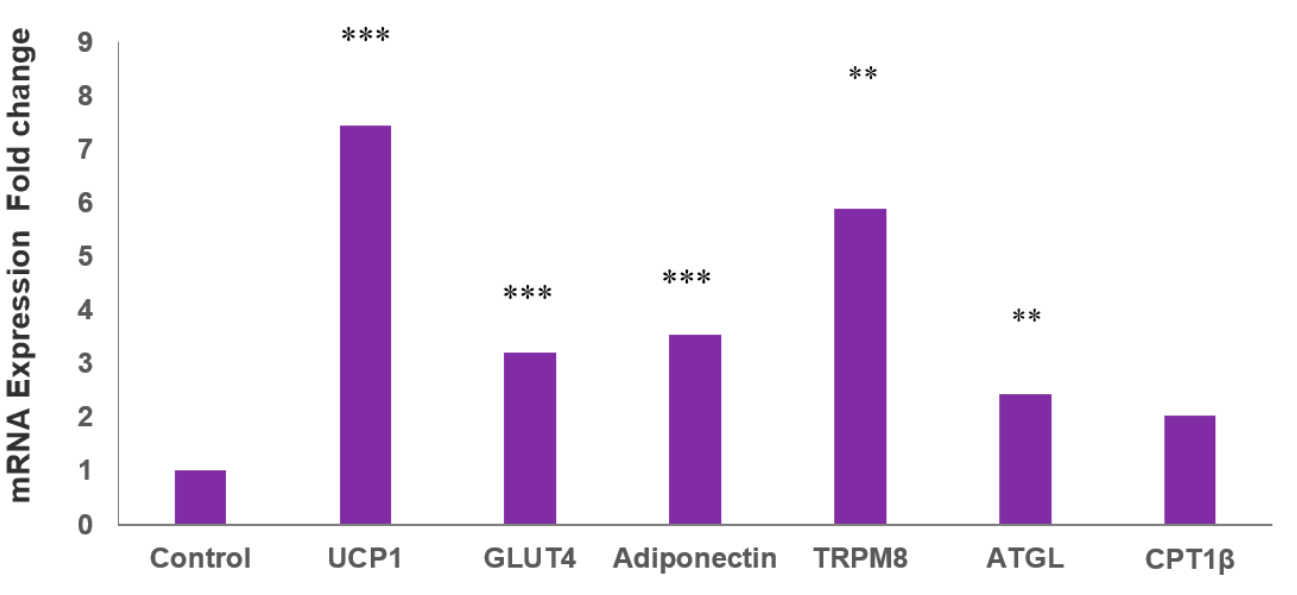
Figure 4. mRNA expression in human adipocytes (HASCs) treated with MLR-1023. qRT-PCR assays were conducted in duplicates following MLR-1023 (60 µ M) treatment of HASCs from three obese donors (four technical replicates each) for seven days compared to untreated adipocytes (control). The results are presented as mean ± SE, ** p ≤ 0.01. *** p ≤ 0.001 compared to the control.